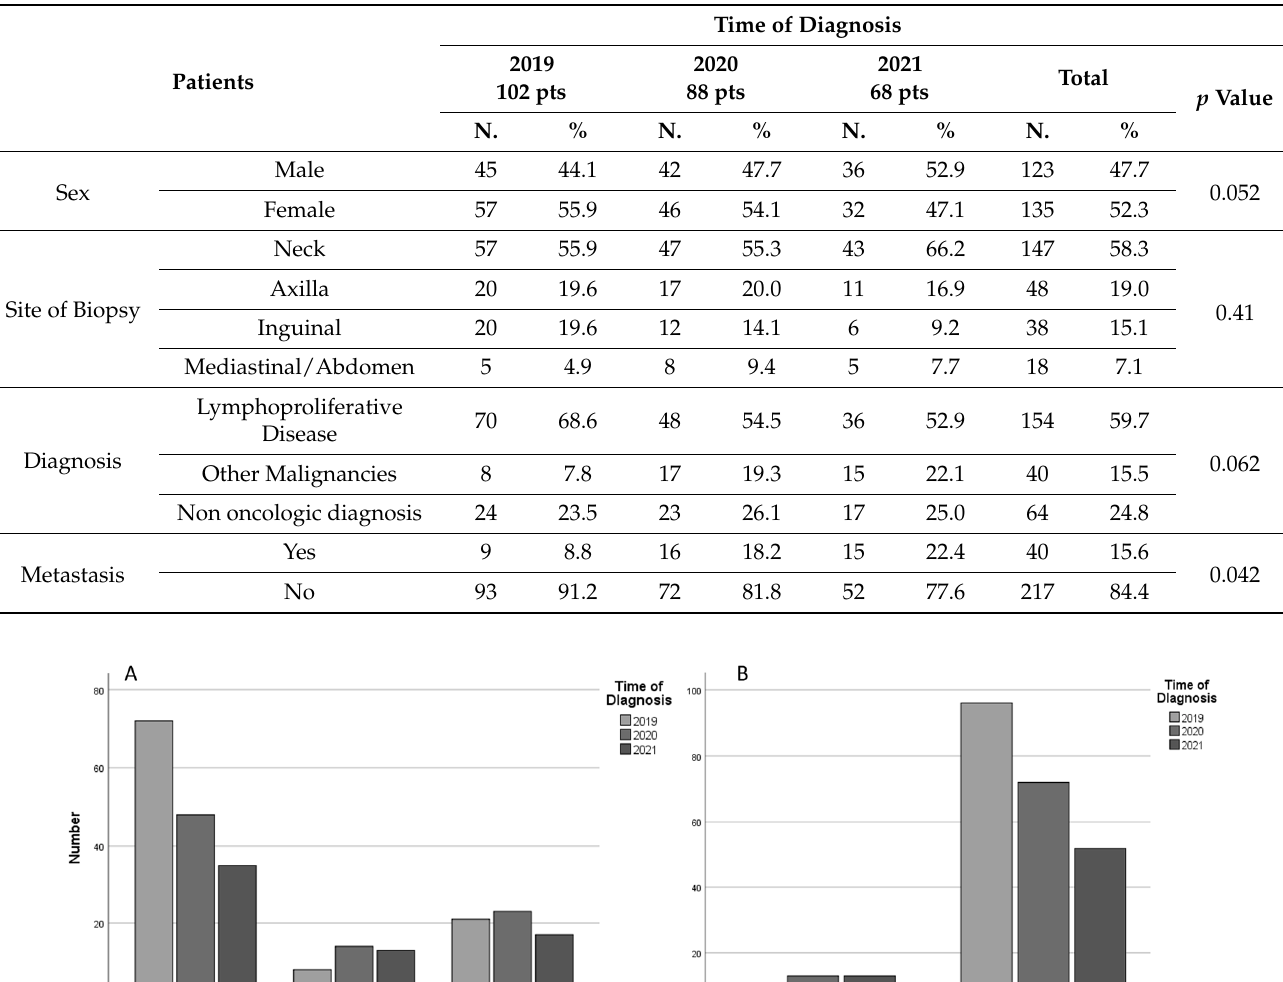
ported on the right side.